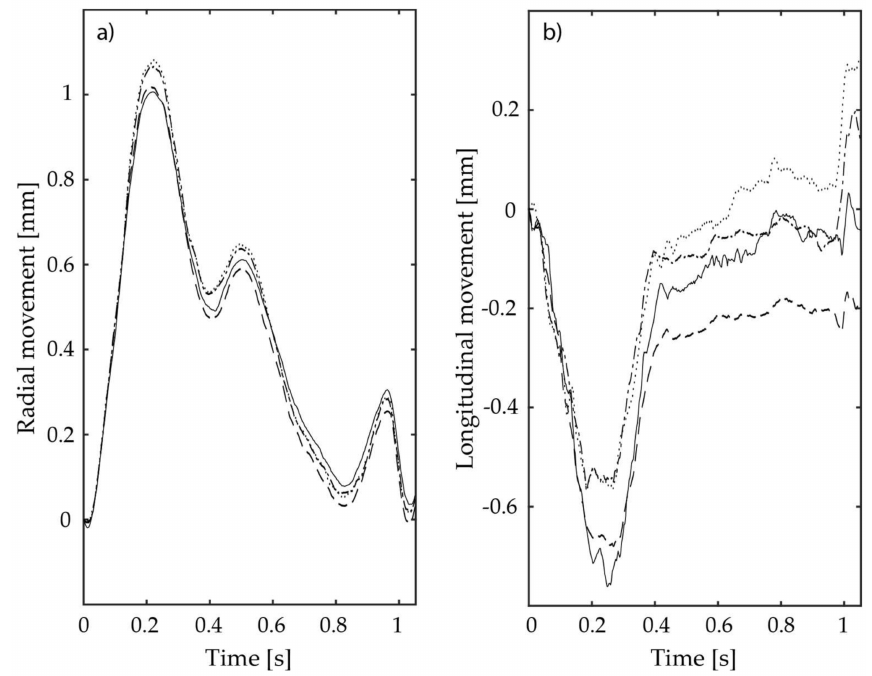
Figure 9. Radial movement ( a ) and longitudinal movement ( b ) of the intima–media complex of the common carotid artery wall of a healthy 35-year-old female. The kernels for the solid, dashed, dash-dot, and dotted lines were placed in order from left to right, respectively, in the first frame cine loop. The head was to the left of the image and the heart to the right. The frames were sampled at 1500 Hz and the proposed tracking scheme had an initial length of iteration of k = 32